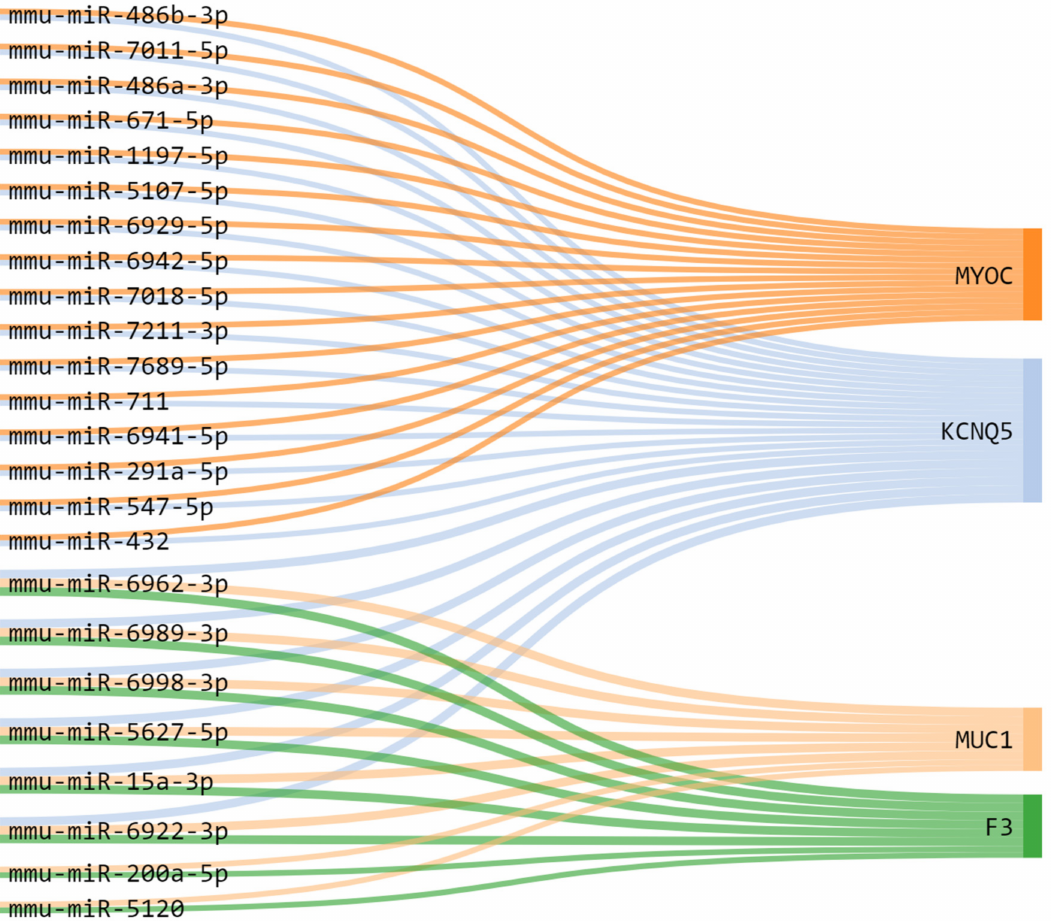
Figure 9. Dysregulated targets genes and potential association with micro-RNA (miRNA) in prostate tumor tissues. Alluvial diagram connecting the representative miRNA-mRNA targets, associated with genes clusters upregulated ( MUC1 and F3 ) and downregulated ( MYOC and KCNQ5 ) in PRAD. Note the Highlight for mmu-miR-6962-3p, mmu-miR-6989-3p, mmu-miR-6998-3p, mmu-miR-5627-5p, mmu-miR-15a-3p, and mmu-miR-6922-3p regulating MUC1 , F3 and KCNQ5